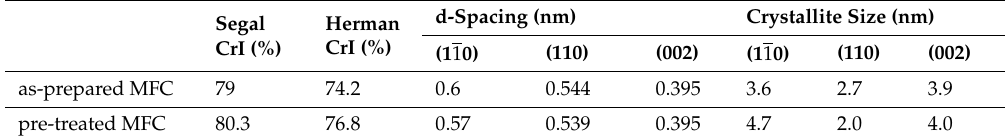
Table 3. Crystalline index (Equation (1a,b)), d-spacing (Equation (3)), and crystal size (Equation (4)).